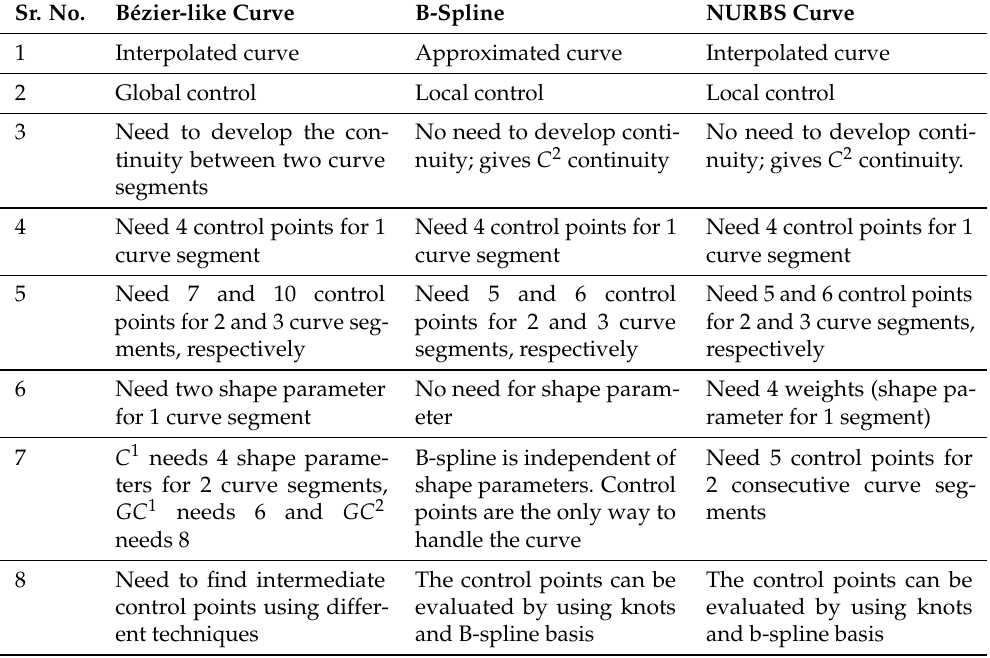
Table 3. Comparison of cubic Bézier-like, B-Spline and NURBS curve. Sr.